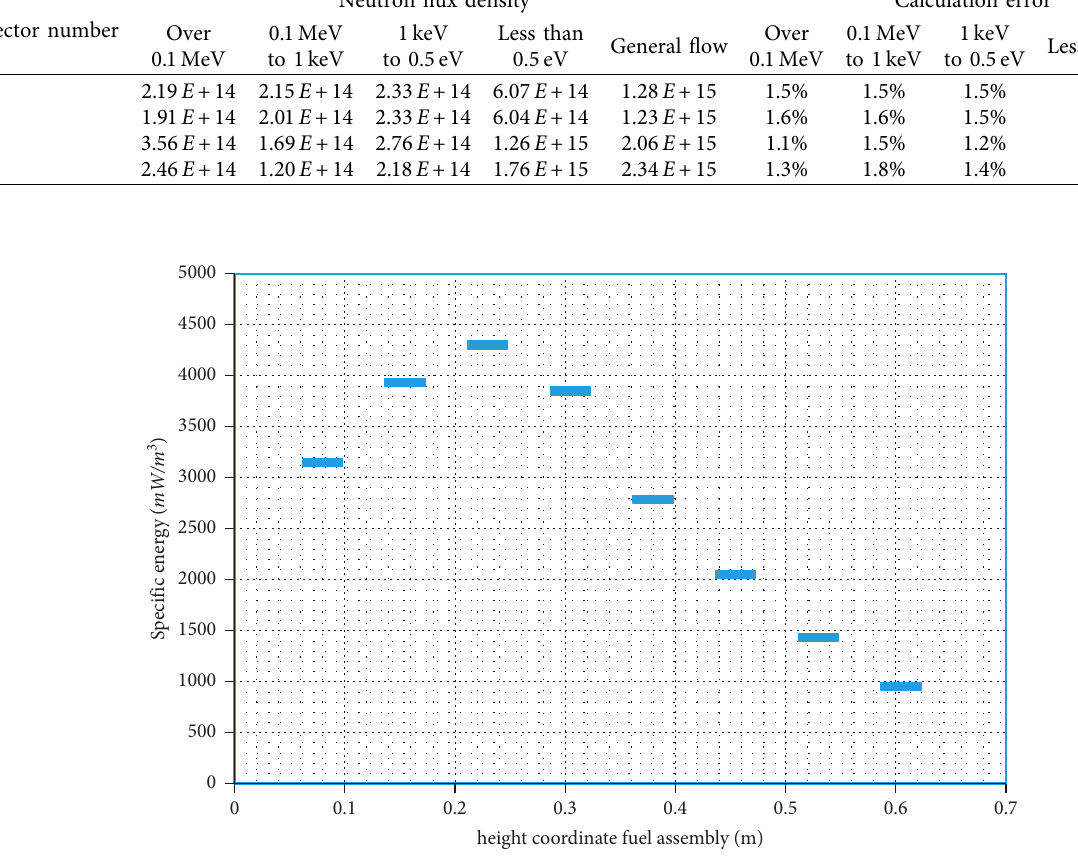
Figure 4: Estimated distribution of specific energy release over the height of the maximum heat-stressed fuel